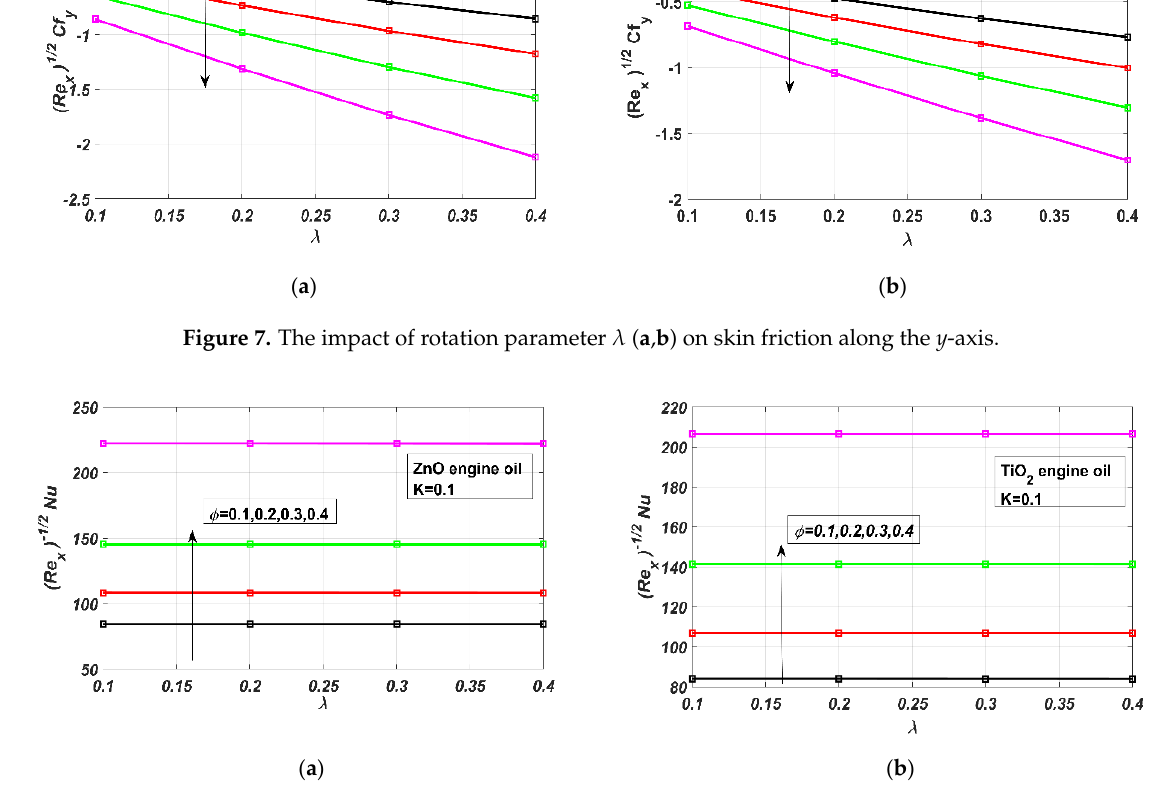
Figure 8. The impact of rotation parameter (cid:2019) ( a , b ) on the Nusselt Number ((cid:1840)(cid:1873)) .